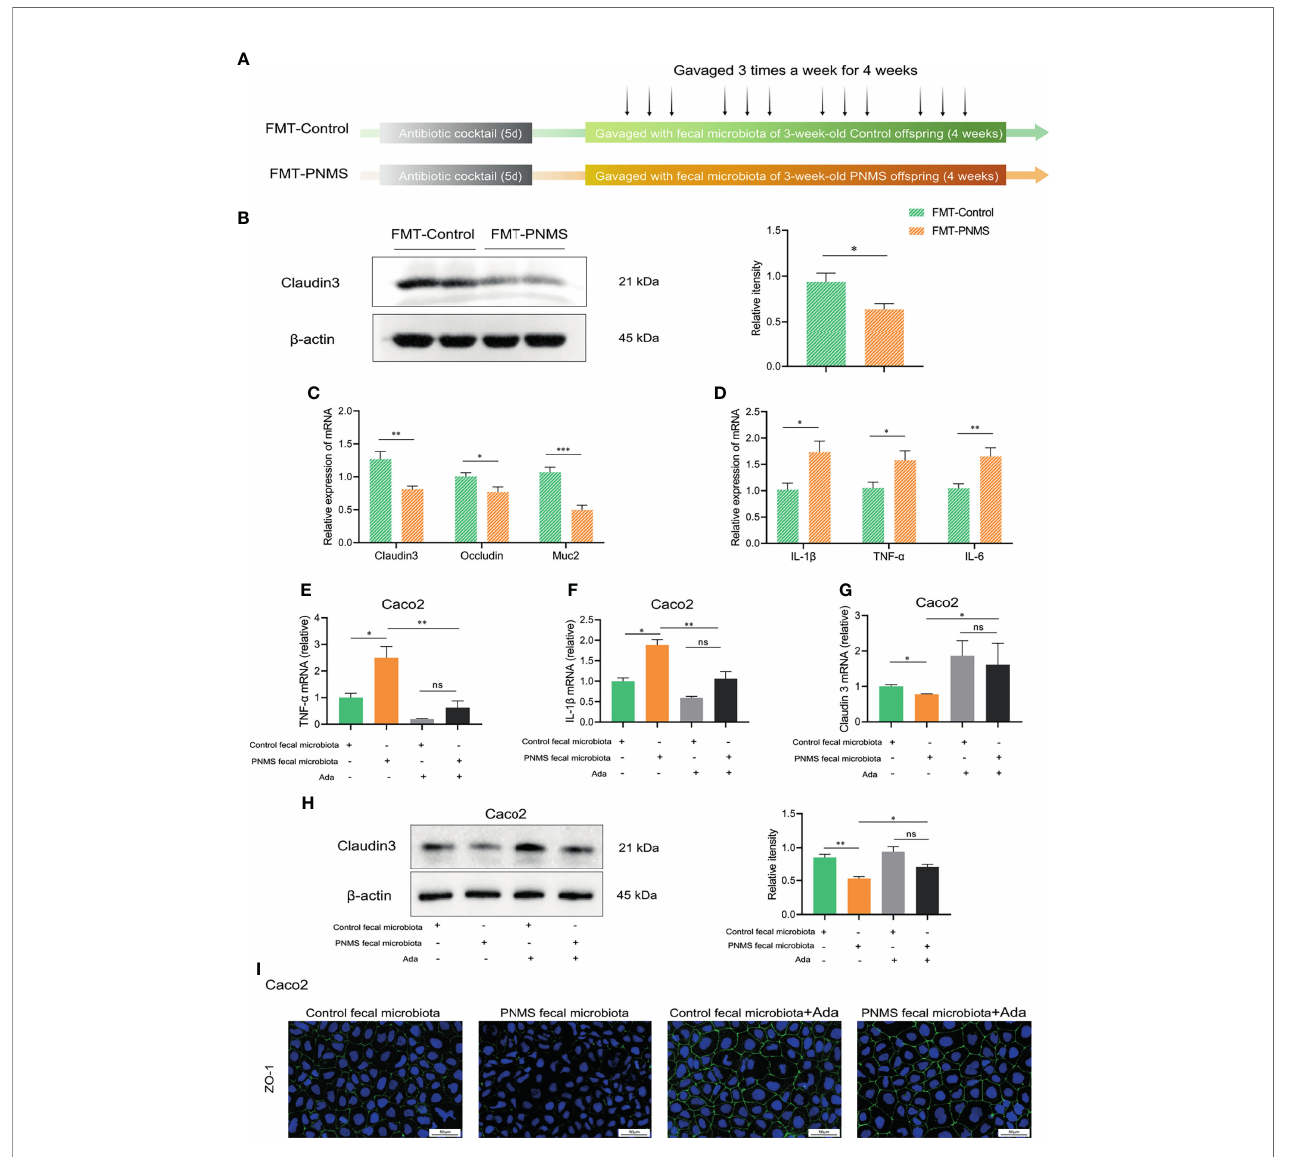
FIGURE 5 | Fecal microbiota from PNMS offspring impaired the gut barrier function and induced low-grade in fl ammation. (A) Experimental work fl ow. (B) Detection of claudin 3 protein by Western blotting. (C) Quanti fi cation of the relative mRNA expression levels of claudin 3, occludin, and Muc2. (D) mRNA levels of the in fl ammatory cytokines in the colon. (E – I) Treatment of Caco-2 cells with the fecal bacterial solution from the control and 3-week-old PNMS offspring mice alone or in combination with adalimumab. (E, F) Expressions of TNF- a and IL-1 b assessed by quantitative PCR (qPCR). (G, H) Expression of claudin 3 assessed by Western blot and qPCR. (I) Fluorescence images for ZO-1. FMT , fecal microbiota transplantation; PNMS , prenatal maternal stress; Ada , adalimumab. Scale bar , 50 m m. Magni fi cation, ×400. * p < 0.05, ** p < 0.01, *** p < 0.001. FMT-control ( n = 5) vs . FMT-PNMS ( n = 5). ns, P <